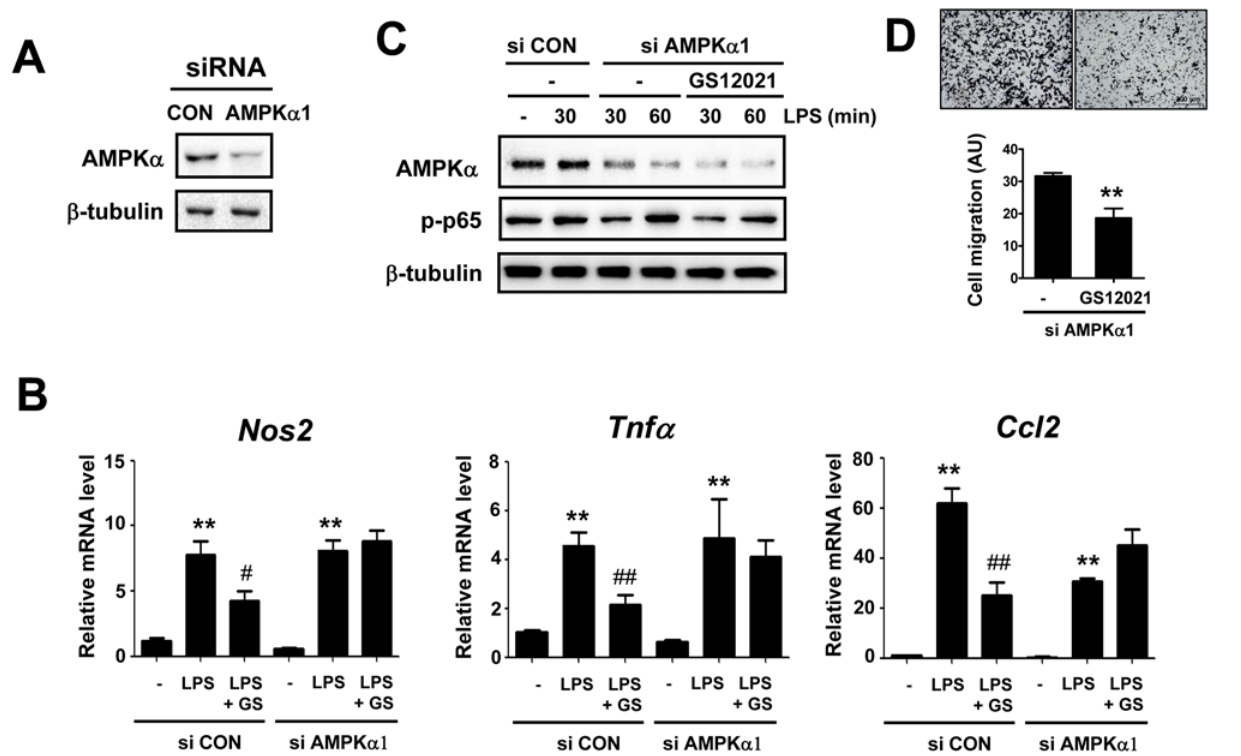
Fig 7. Anti-inflammatory effect, but not anti-chemotaxis effect, of GS12021 was attenuated in AMPK α 1 knockdown cells. RAW 264.7 cells were transfected with siRNA of control (CON) or AMPK α 1 and incubated for 24 h. Cells were subsequently treated with LPS or GS12021+LPS and mRNA or protein levels were determined. (A) AMPK α expression after siRNA transfection. (B) mRNA levels of iNOS, TNF α , and MCP-1/CCL2 in AMPK α 1 knockdown macrophages. ** P < 0.01 versus vehicle; # P < 0.05, ## P < 0.01 versus LPS alone. (C)-(D) The effect of AMPK α 1 knockdown on the GS12021 suppression of p-p65 and the adipocyte CM-mediated macrophage chemotaxis. Representative microphotographs of cell migration are shown above the quantification results (N = 3). AU means arbitrary units. ** P < 0.01 versus